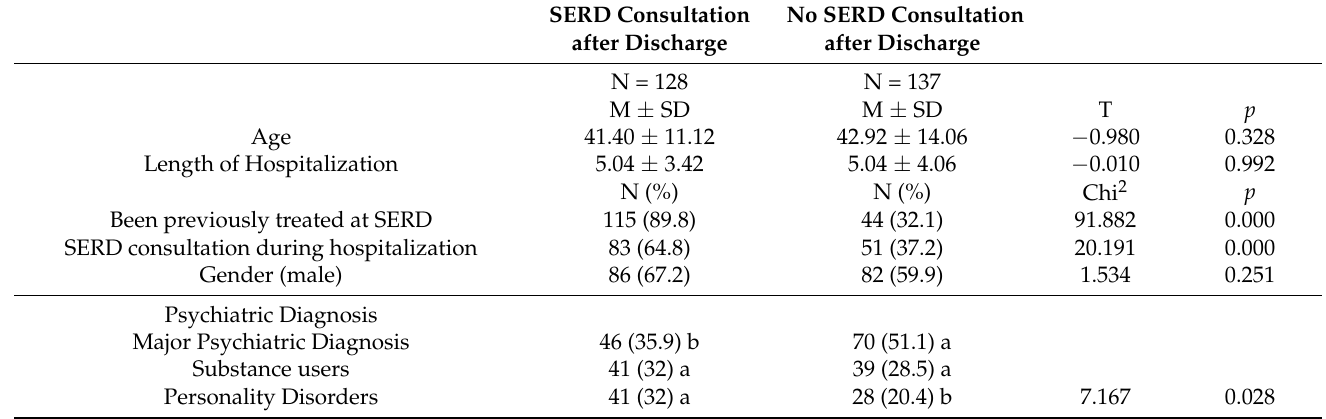
Table 2. Differences between patients who attended and did not attend hospital post-discharge appointments at